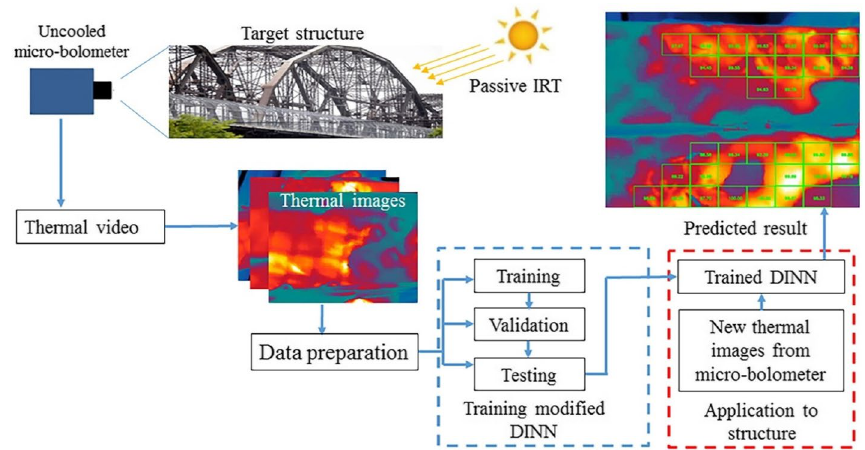
Fig. 9 The subsurface damage detection method proposed by Ali and Cha